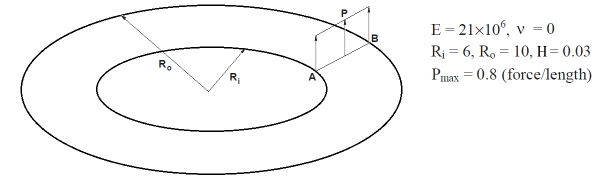
Figure 5. The slit annular plate loaded with the line force P .